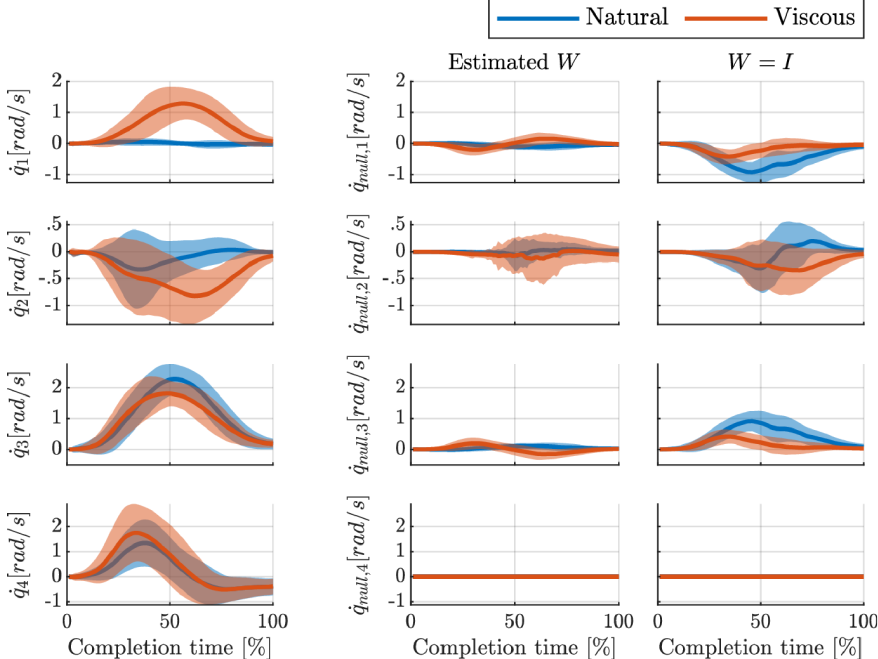
Fig 7. Extracted null-space velocities based on two different assumptions about the weight matrix. The first column shows the average velocity profiles over all subjects for Target 1. The Second column shows the extracted null- space velocity using the estimated weight matrix for each participant. The third column illustrates the null-space velocity when W = I is used.